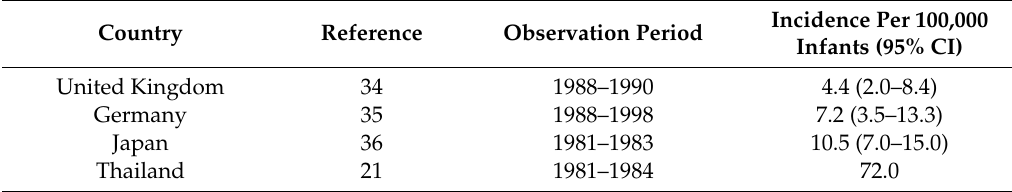
Table 5. Incidence of late-onset VKDB in di ff erent